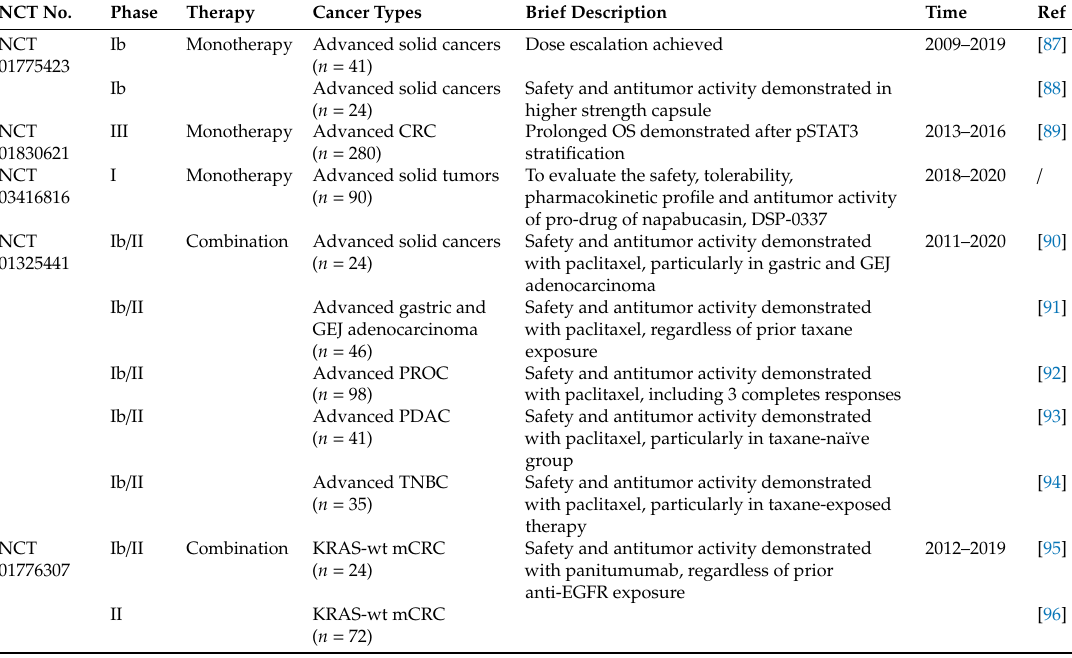
Table 1. Clinical trials of napabucasin: cancer stemness inhibitor targeting STAT3-driven gene